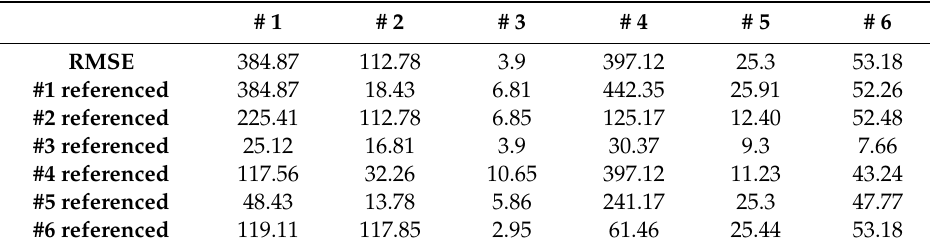
Table 5. Statistics of RMSE.